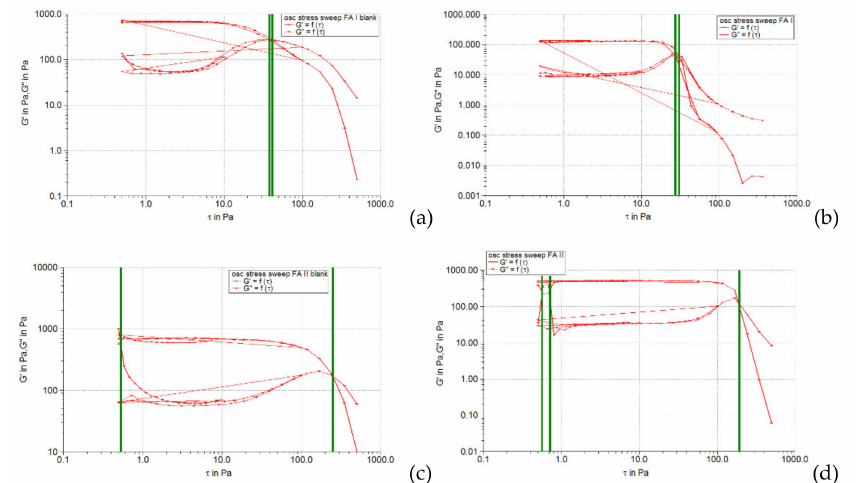
Figure 3. The behavior of viscoelastic modules G’ and G” depending on the shear stress for hydrogels based on Carbopol 940 and isopropyl alcohol, simple or loaded with caffeic acid liposomes: ( a ) FAI blank, ( b ) FAI, ( c ) FAII blank, ( d )